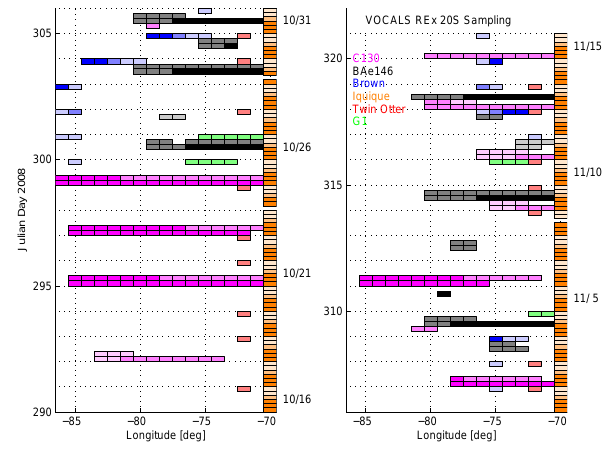
Fig. 1. VOCALS REx sampling within 1 ◦ latitude of 20 ◦ S. Platforms are color coded and shaded by the measurement time (darkest: 00:00–12:00UTC (night and dawn), medium: 12:00– 16:00UTC (morning transition), light: 16:00–24:00UTC (midday and